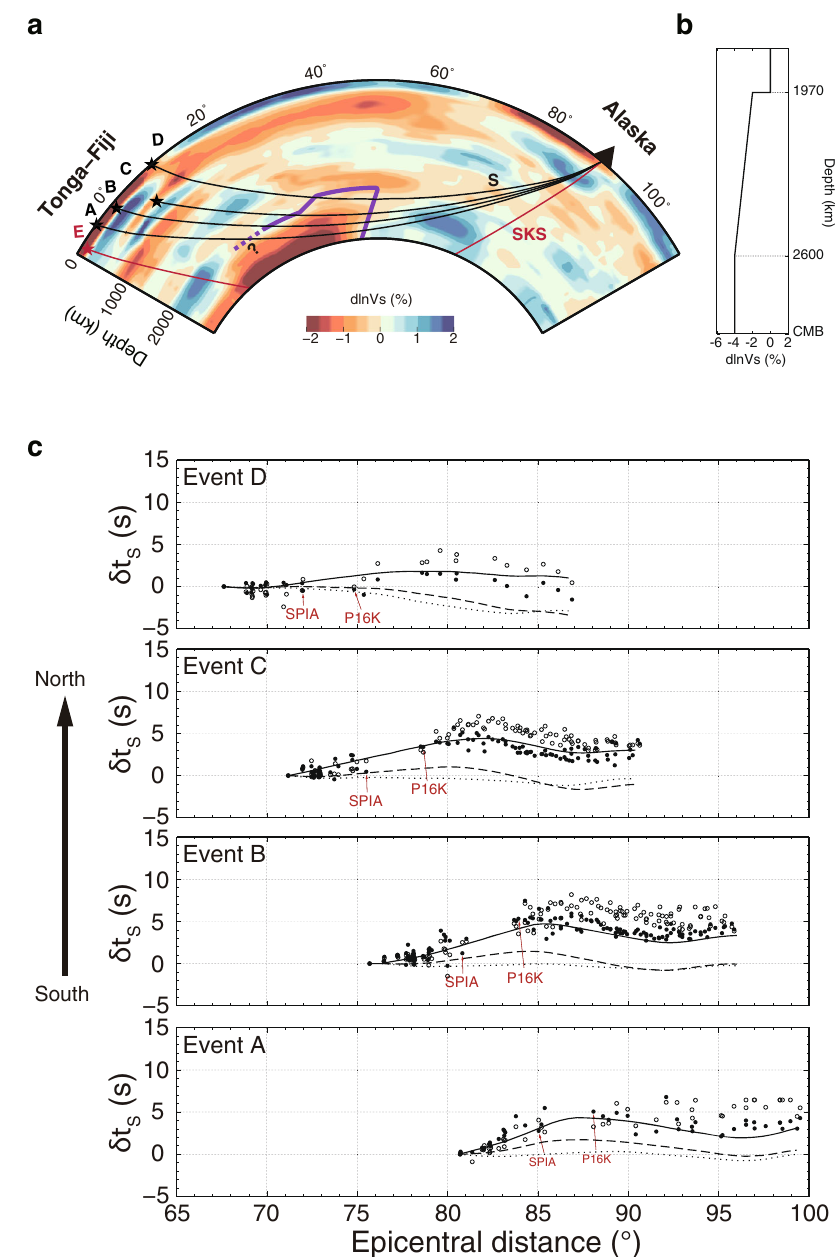
Fig. 3 The northern edge of the Paci fi c Large Low-Velocity Province. a Depth cross-section from Tonga-Fiji to Alaska in the GyPSuM model 5 . The ray paths of S (black) and SKS (red) are plotted at one common station from different events (stars). The purple line outlines our inferred Large Low-Velocity Province (LLVP) while the southernmost portion (purple dashed line) is not well constrained. b Shear wave velocity perturbation with depth relative to the IASP91 velocity model 34 in our inferred LLVP. c S travel time residuals (open circles) relative to the IASP91 velocity model 34 and after correction (solid circles) using SKS travel time residuals in Supplementary Fig. 2, along with predictions from the GyPSuM model (dashed line), GyPSuM at a depth of 0 − 2000 km (dotted line) and the new LLVP model (solid line) in a . Events are arranged from south to north. Two common stations (SPIA and P16K) are highlighted to show different S travel time trends of events A − D. Data are selected in an azimuth range of 0° − jump. In contrast, the S ray paths of events B – D sample above the LLVP at smaller distance and δ t S increases quickly when S tion for events in the Solomon Islands (Supplementary Table 1) samples more LLVP with increasing distance. A velocity drop of recorded by stations at North America provides extra constraints 2% across the top of the LLVP is needed to match the rapid on the basal structure of the LLVP 24,35 in an orthogonal direc- tion. From north to south, δ t S slows up to 5 s (Fig. 4a, Supple- change of δ t S , and the gradual change of velocity perturbation at deeper depth reproduces the travel time anomalies for all events. mentary Fig. 4). The largest gradient of δ t S separating the S-wave turning points in the lowermost mantle is de fi ned as the To match the travel time of S for event A at larger distance, a boundary of the Paci fi c LLVP. When δ t S measured for the W-E uniform δ V S of − 4% is necessary in the lowermost 300 km of the mantle. pro fi le in Fig. 4a are projected on a N-S pro fi le (Fig. 4b) at their